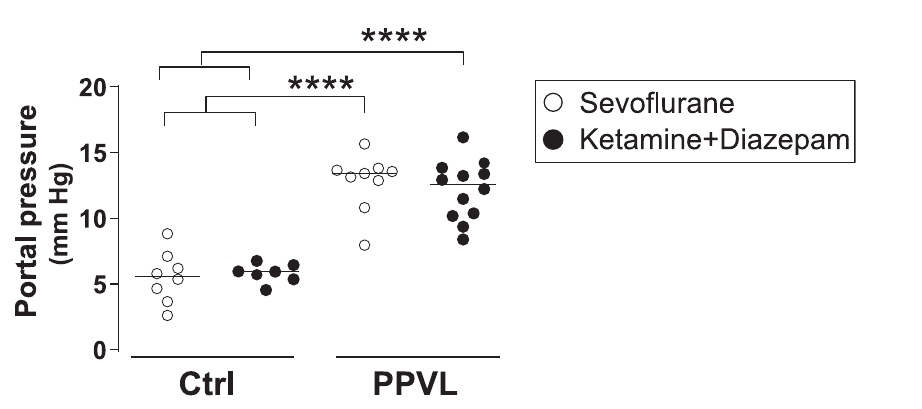
Fig 4. Portal pressure (mmHg) in normal rats (Ctrl) and rats with partial portal vein ligation (PPVL) anesthetized with sevoflurane (Sevo) or ketamine+diazepam (KD). ���� p < 0.0001 One-way ANOVA with Tukey’s post-hoc tests. The line and dots represent the median and individual rat values,